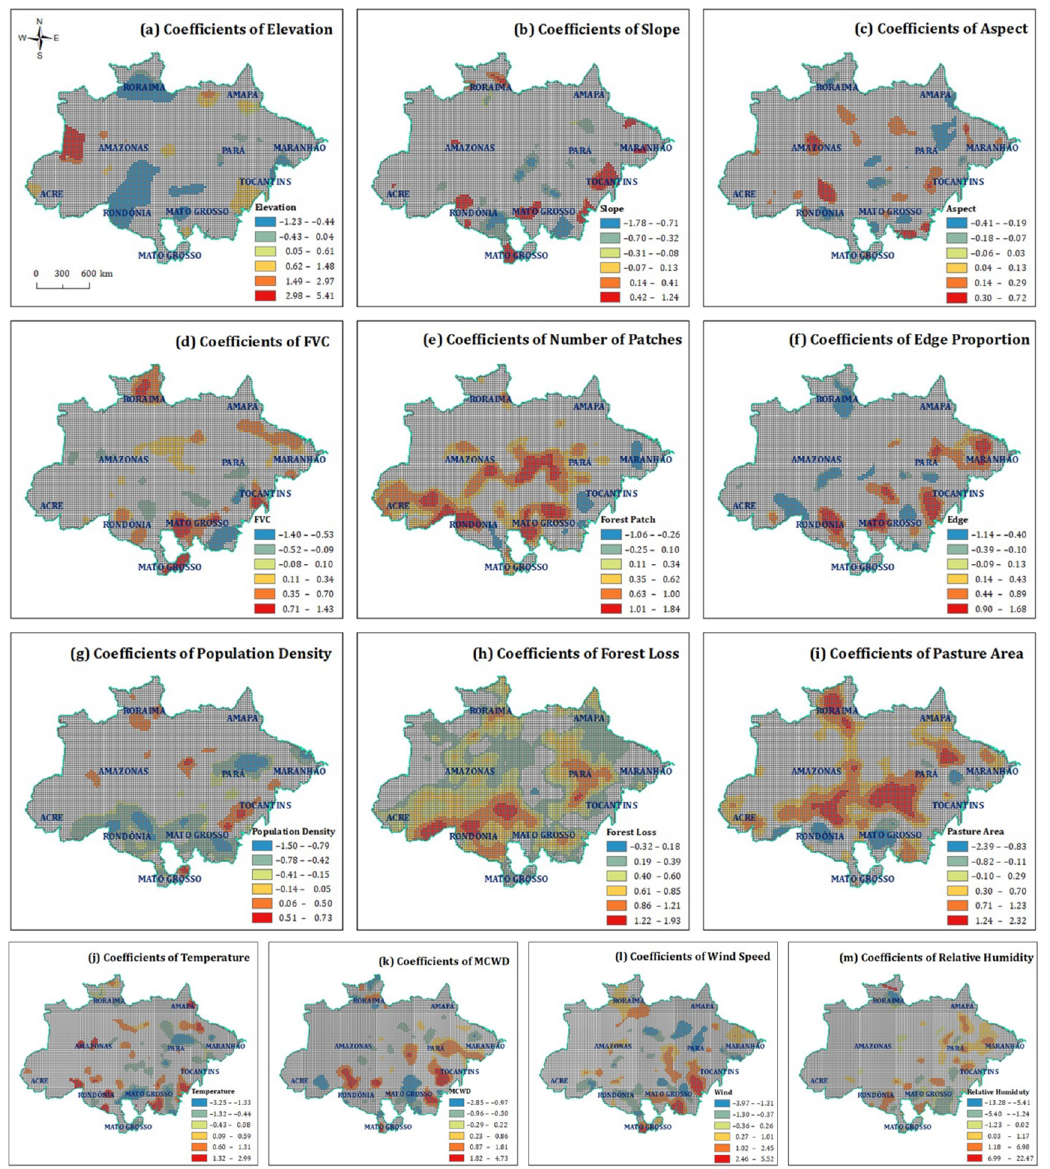
Figure 6. Spatial distribution of significant model coefficients of GWGR. ( a ) Elevation, ( b ) Slope, ( c ) Aspect, ( d ) FVC, ( e ) Number of Forest Patches, ( f ) Edge Proportion, ( g ) Population Density, ( h ) Forest Loss, ( i ) Pasture Area, ( j ) Temperature, ( k ) Maximum Cumulative Water Deficit, ( l ) Wind Speed, ( m ) Relative Humidity.